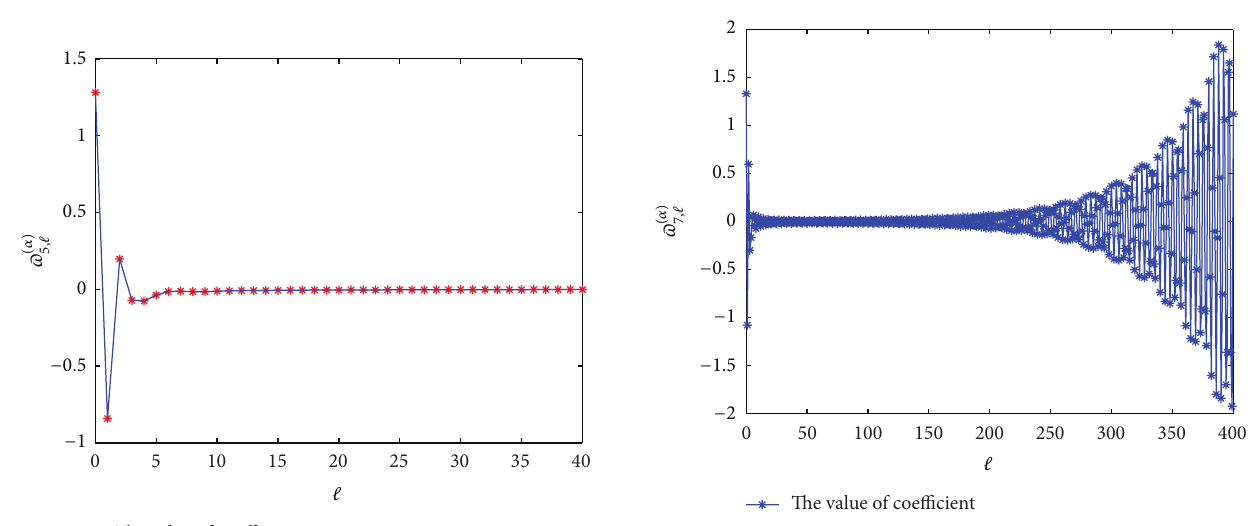
Figure 2: The values of the coefficients 𝜛 (𝛼) 4,ℓ (ℓ = 0,1,...) for 𝛼 = 0.3 .